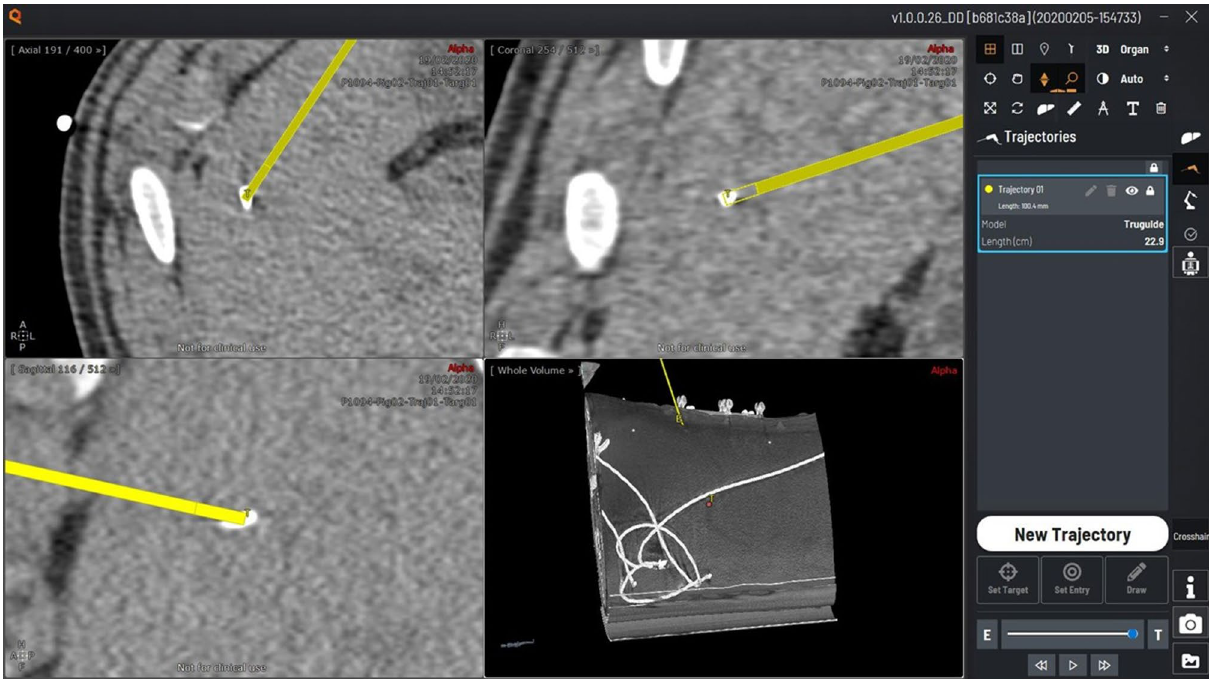
Figure 7. Definition of orbital and cranio-caudal